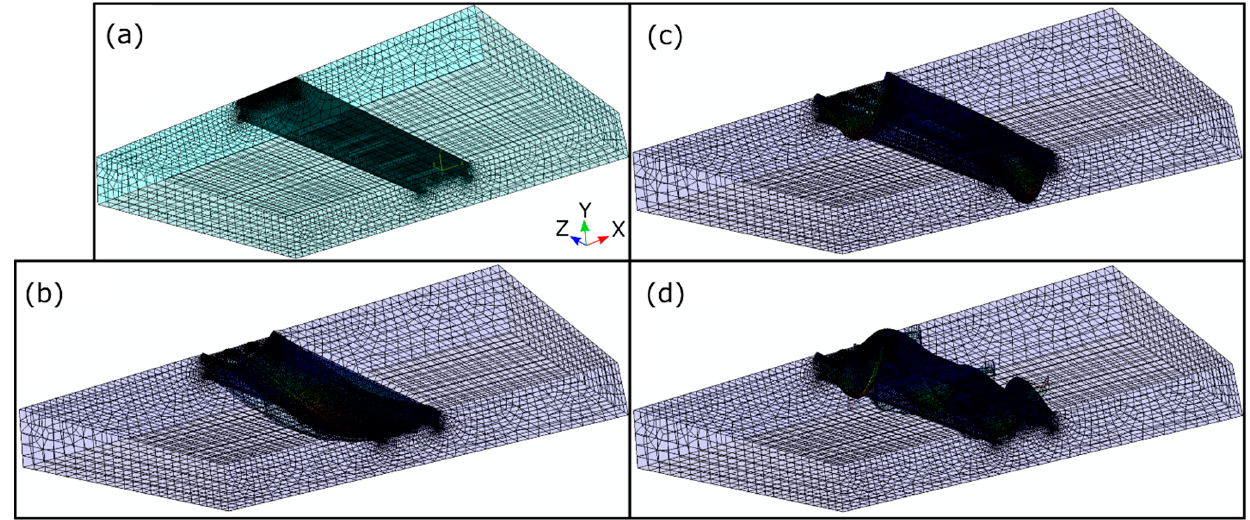
Figure 5. FEM of the full-scale bridge and its dominant modes in the dry condition: ( a ) undeformed FEM; ( b ) 1st mode shape; ( c ) 4th mode shape; ( d ) 9th mode shape. The model is colored by normal- ized displacement magnitude.